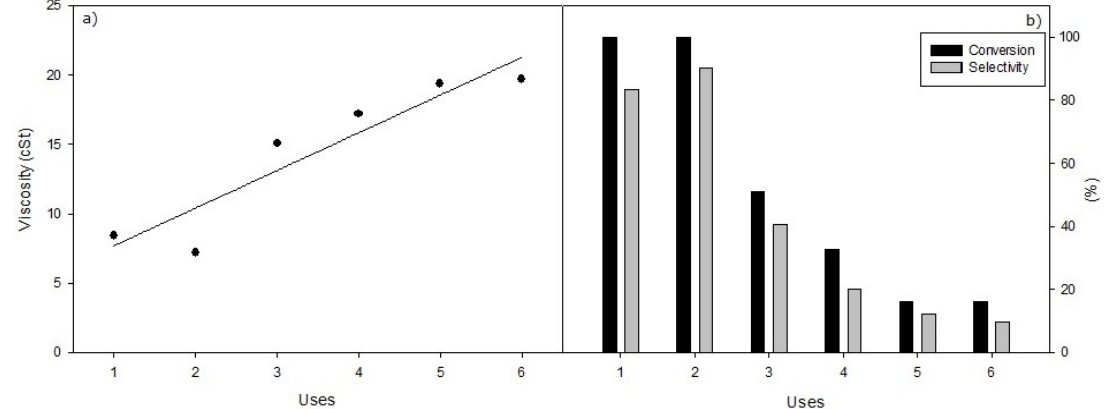
Figure 7. ( a ) Viscosity values obtained in the successive reuses of heterogeneous selective methanolysis of sunflower oil (viscosity 32.0 cSt) under standard conditions, with 0.8 g of KF/ZnO, 65 °C, 12 mL of oil and 2.43 mL methanol. ( b ) Conversion and Selectivity values obtained with identical conditions.